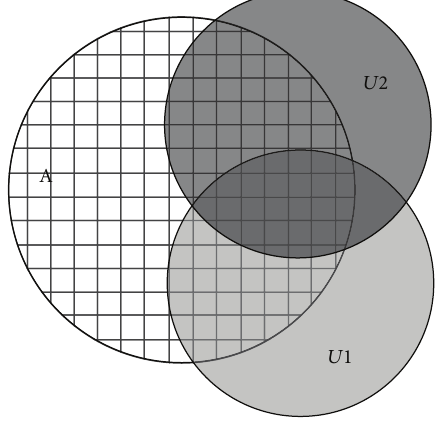
Figure 4: Schematic diagram of network coverage.